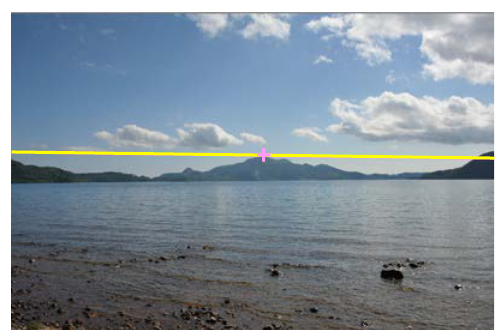
Figure 8. ImageC and measurement result